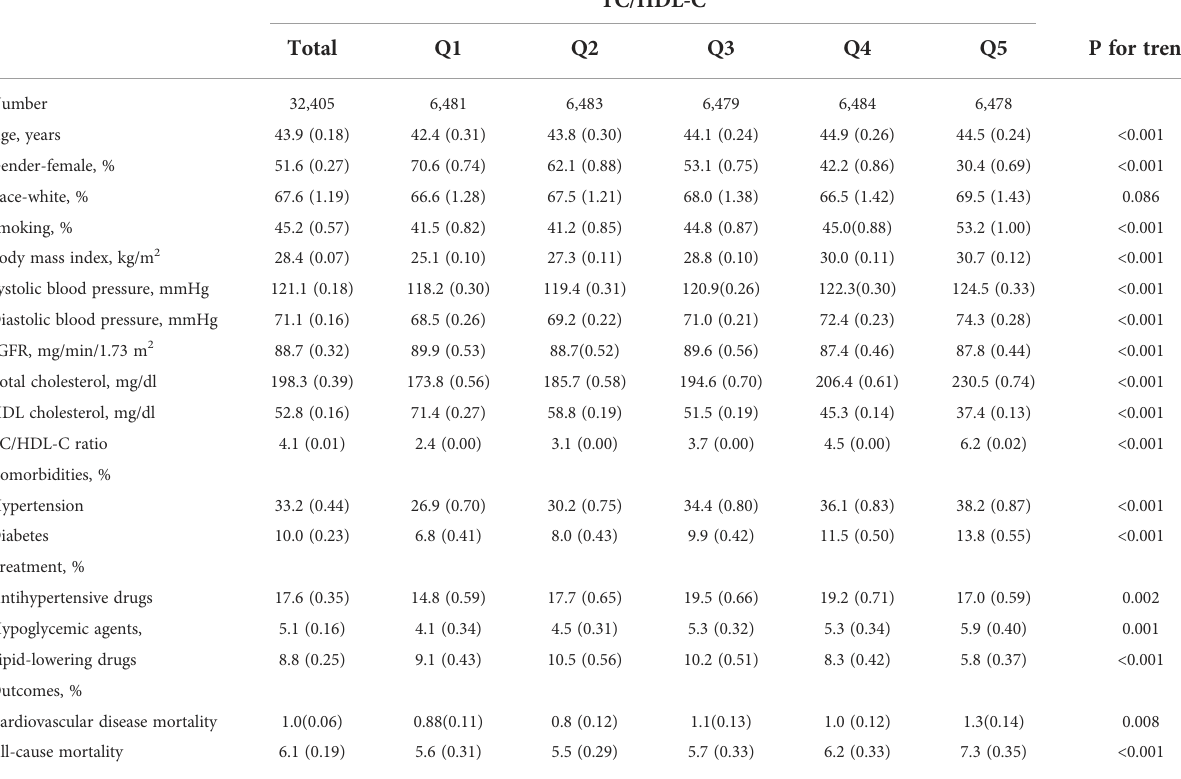
Results are mean (SD) or percentage (number of individuals). Abbreviations:Q,quintiles;TC/HDL-C,totalcholesterol/high-densitylipoproteincholesterol;eGFR,estimatedglomerular fi ltrationrate;Q1,<2.86;Q2,2.86 – 3.46;Q3,3.46 – 4.12;Q4,4.12 – 5.07;